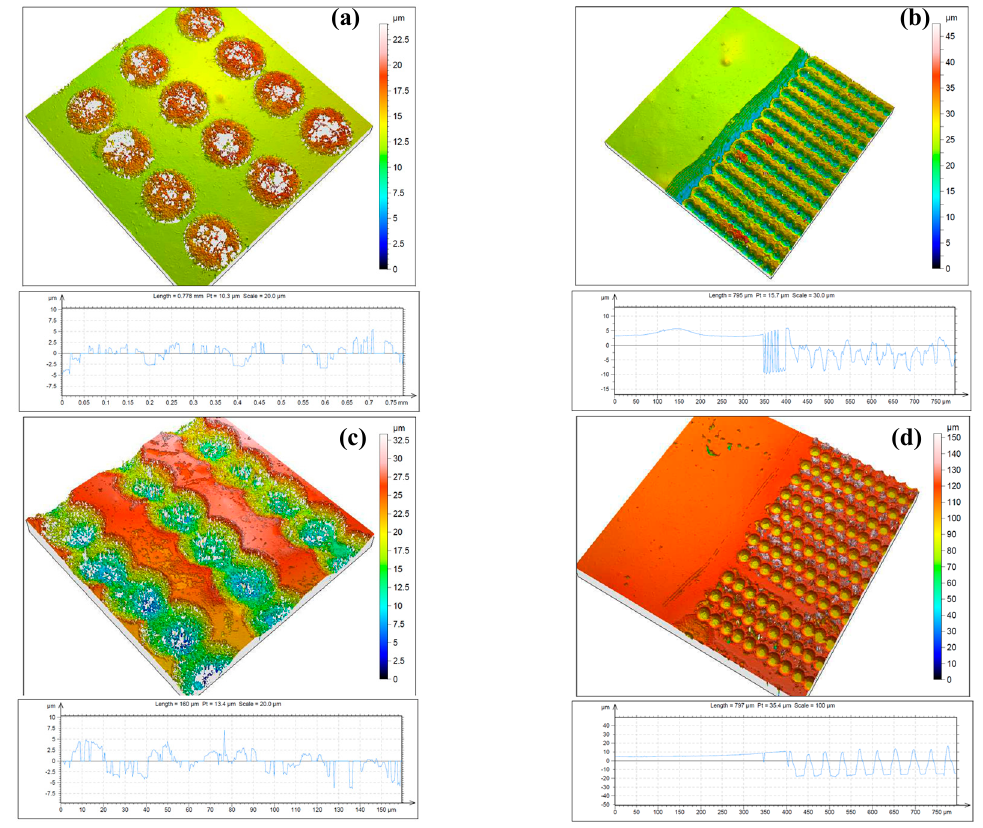
Figure 2. Three-dimensional topography and cross section of thin chitosan films irradiated by femtosecond (fs) laser, λ = 800 nm, τ = 130 fs, obtained by confocal microscopy: ( a ) N = 2, I = 7.9 × 10 14 W/cm 2 ; ( b ) N = 5, I = 7.9 × 10 14 W/cm 2 ; ( c ) N = 2, I = 1.5 × 10 15 W/cm 2 ; ( d ) N = 5, I = 1.5 × 10 15 W/cm 2 .